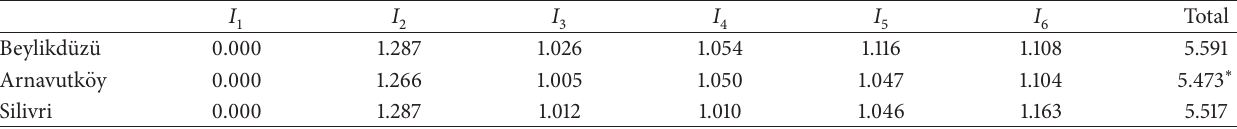
Table 10: Unit Index for weighted information contents for European Side of Istanbul.